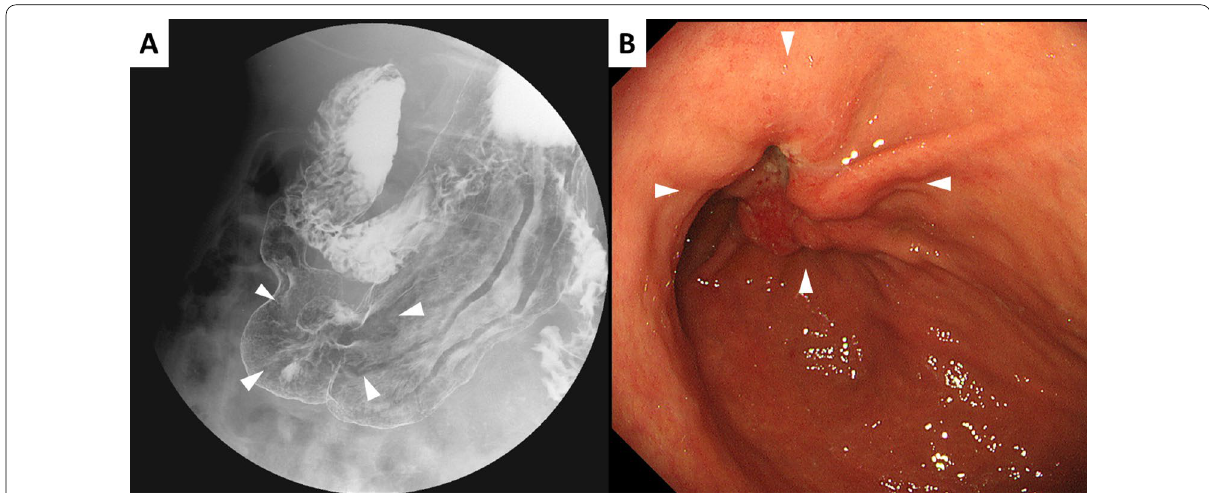
Fig. 1 A Upper gastrointestinal imaging of the double contrast study in the prone position revealed an inverted image of the upper gastrointestinal tract and an irregular attachment of barium in the anterior wall of the stomach (white arrowhead). B Upper endoscopy showed an elevated lesion in the anterior wall of the stomach body (white arrowhead)